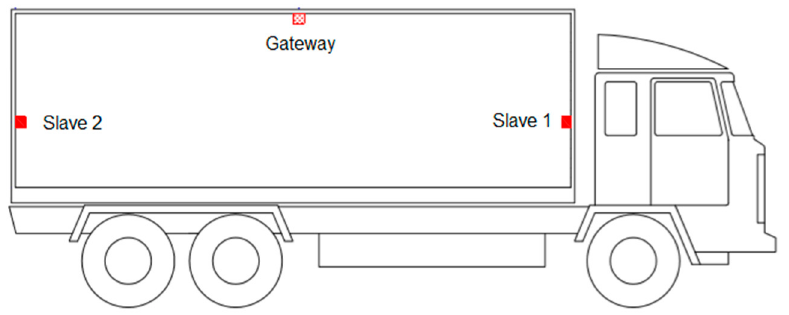
Figure 15. Distribution of the nodes during land transportation.